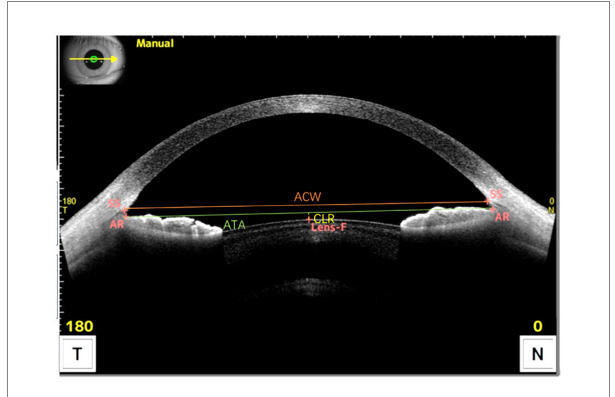
FIGURE 1 Measurement of the anterior segment parameters with CASIA2 OCT. ACW was defined as the distance between the scleral spurs on the nasal and temporal sides. ATA was defined as the distance between the angle recesses on the nasal and temporal sides. CLR was defined as the anteroposterior distance between the anterior crystalline lens surface and the angle recess to angle recess line. SS, Scleral Spur; AR, Angle Recess; Lens-F, anterior surface of the crystalline lens. The solid orange line is ACW, the solid green line is ATA, and the dashed yellow line is CLR.